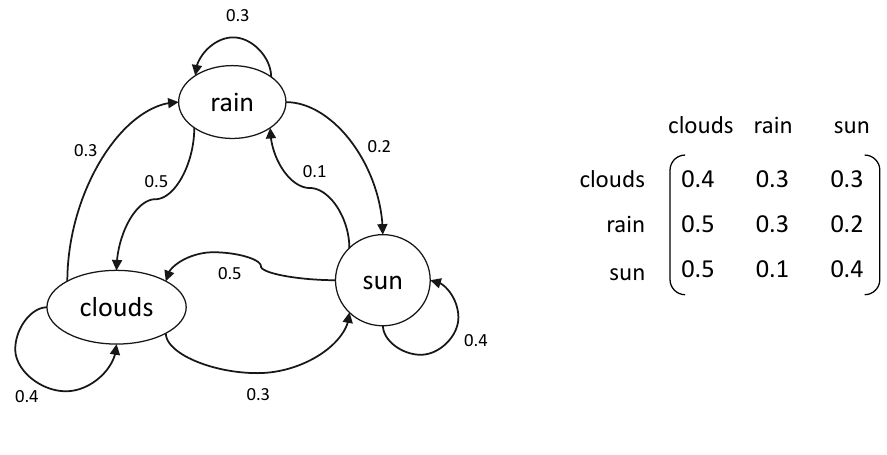
Figure 2. An example of a Markov chain, displayed as both a state diagram ( left ) and a matrix with transition probabilities ( right